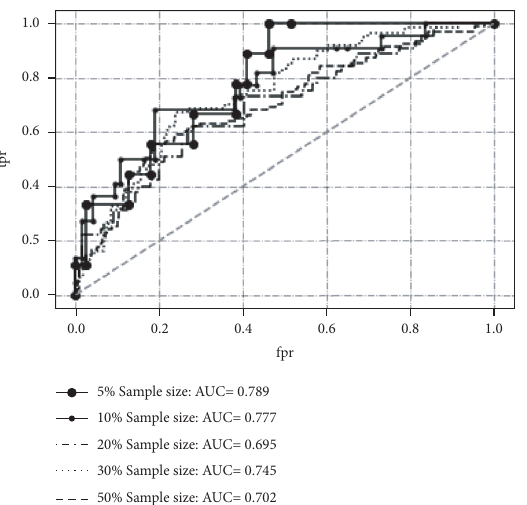
Figure 8: The ROC curve and AUC value of the model were established with a small sample data